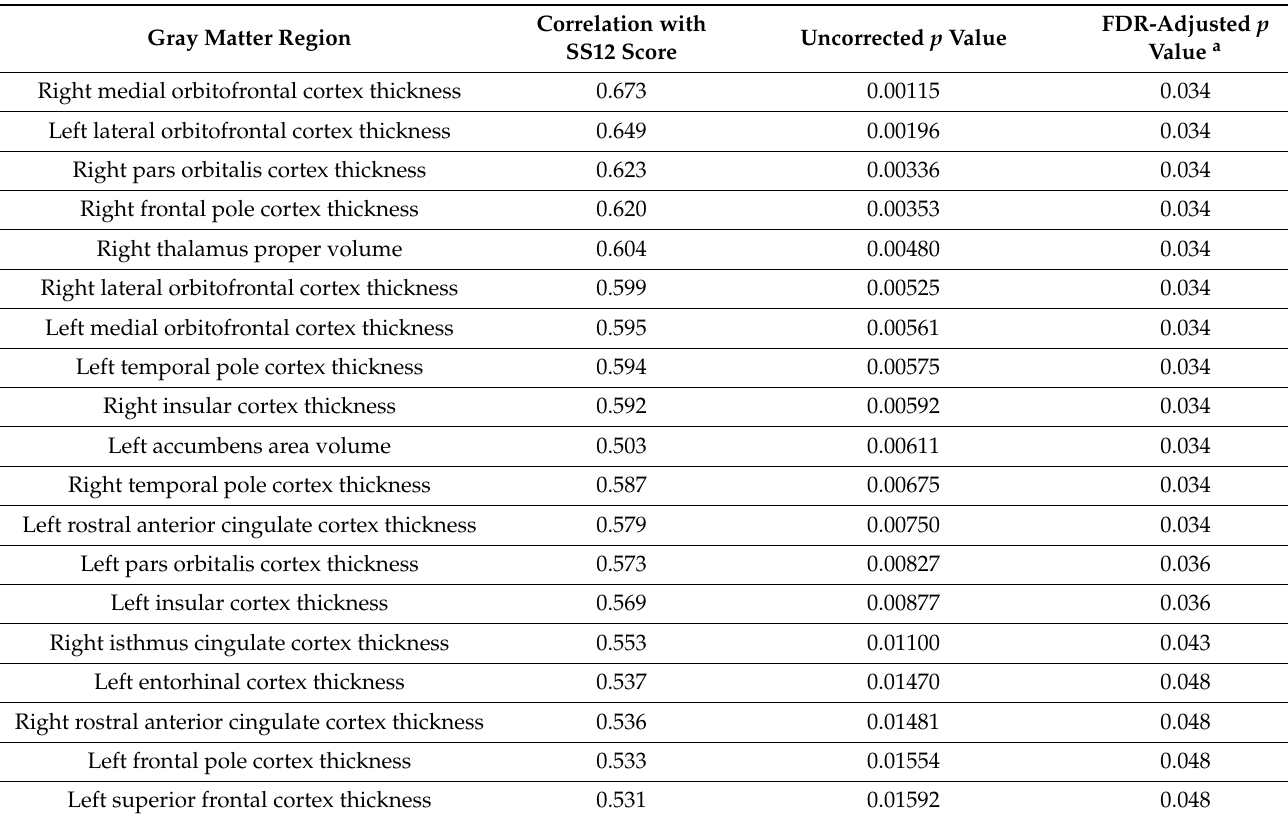
Table 3. Statistically significant correlations between lower SS12 scores and regional gray matter atrophy in patients with Alzheimer’s disease, without adjustment for possible